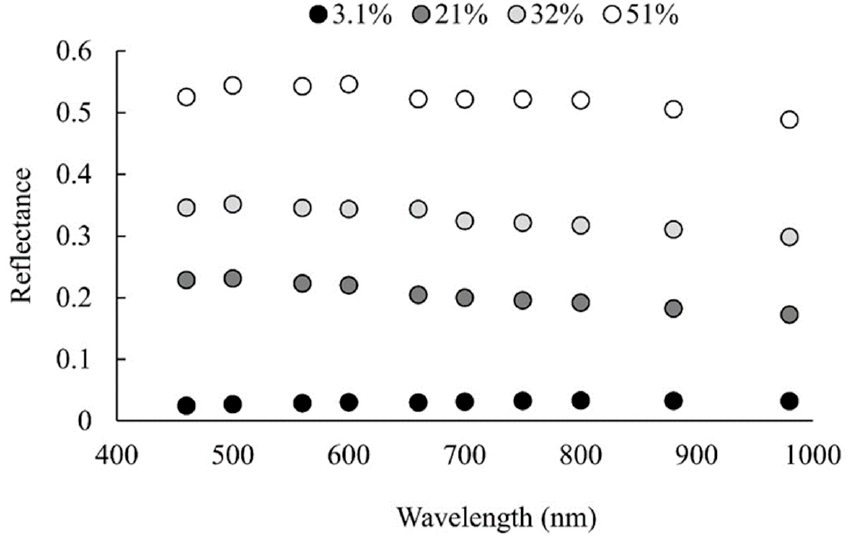
Figure A1. Measured reflectance values of the reference tarps with 3.1%, 21%, 32%, and 51% reflectances for a range of wavelengths using the CropScan multispectral radiometer.